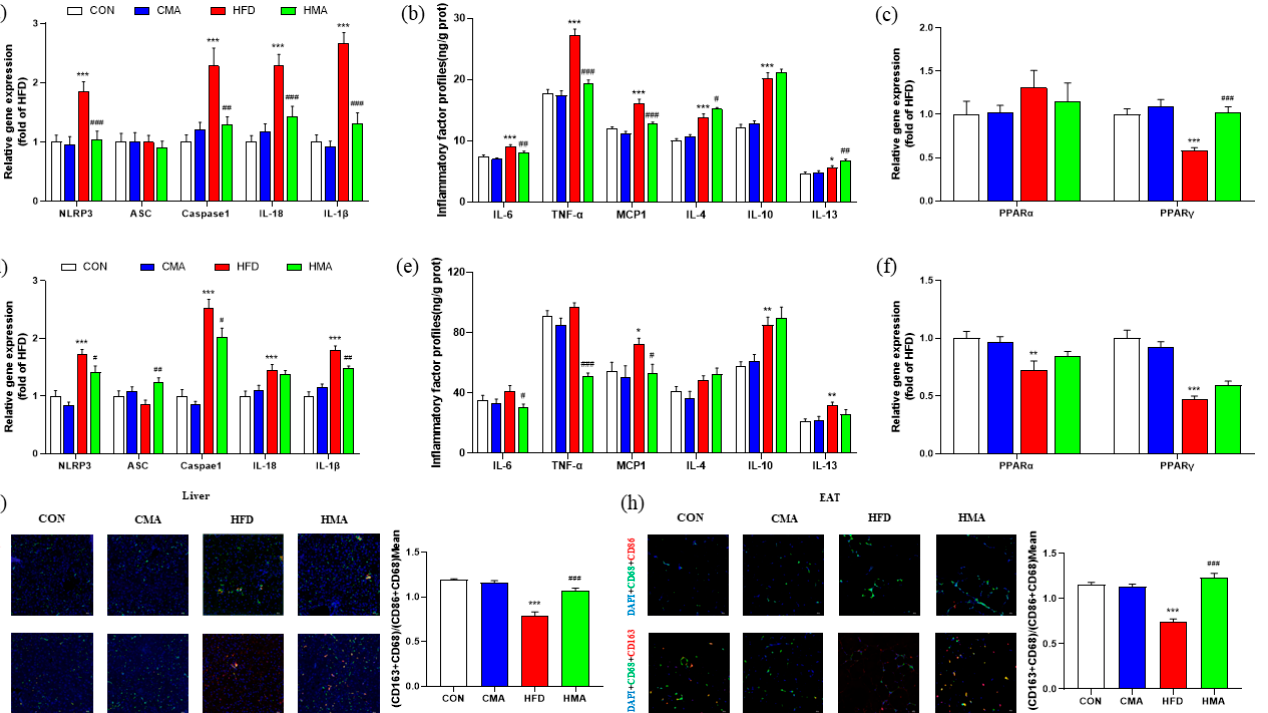
Figure 5. Effect of MA on inflammatory response in liver tissue and EAT of mice. ( a − c ) Expression of inflammatory genes and content of inflammatory factors in liver tissue. ( d − f ) Expression of inflammatory genes and content of inflammatory factors in EAT. ( g ) Fluorescent labeling of macrophages in liver. ( h ) Fluorescent labeling of EAT macrophages. ( a − f ) Values are expressed as mean ± SEM (n = 10); ( g − h ) values are expressed as mean ± SEM (n = 3 * 3). Differences between the CON group and the CMA and HFD groups are indicated by *. *** p < 0.001, ** p < 0.01, * p < 0.05. Differences between the HFD group and the HMA group are expressed by # . ### p < 0.001, ## p < 0.01, and # p < 0.05.